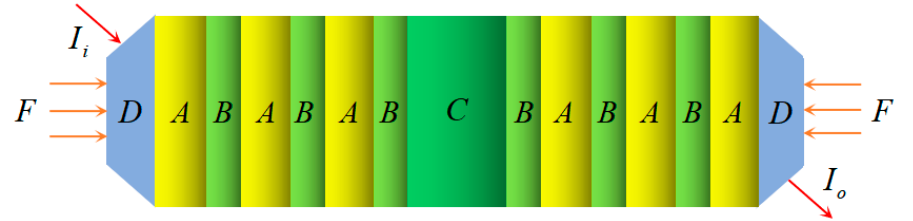
Figure 1. Schematic of defective superconductor photonic crystal. The periodic number is N = 3.